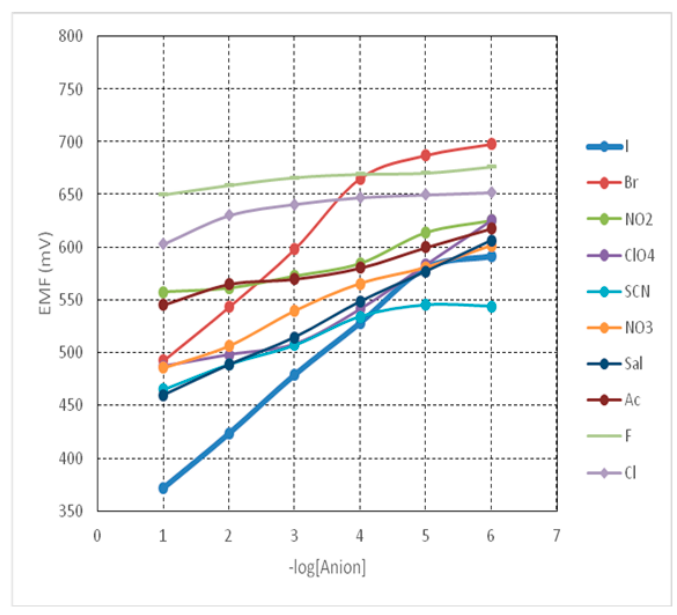
Figure 4. Potentiometric response of sensor C to different anions.